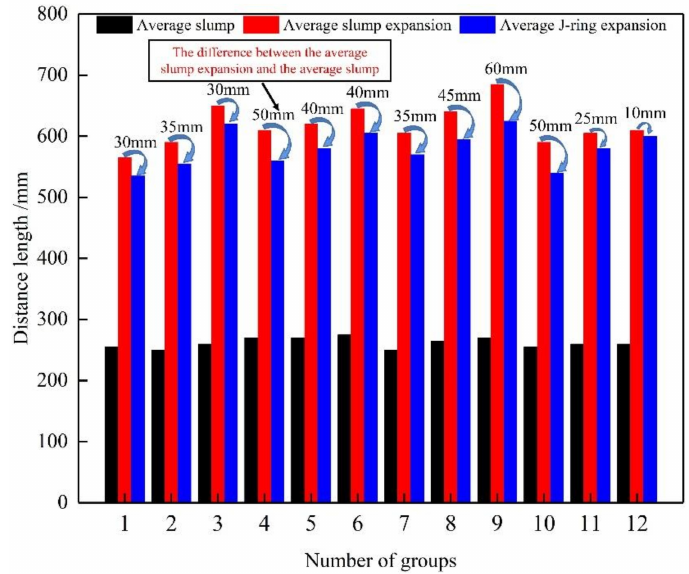
Figure 9. Statistics of apparent quality parameters of